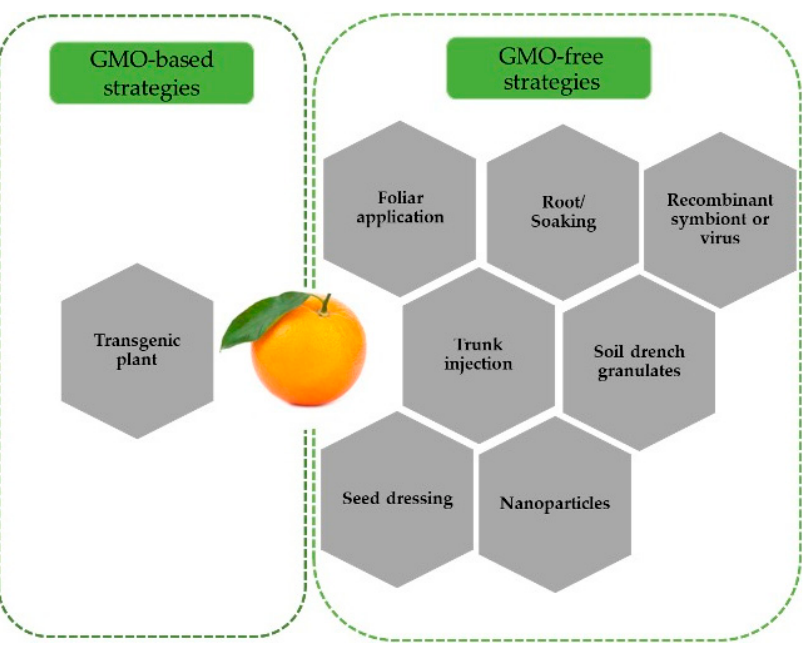
Figure 1. Novel approaches to RNA interference (RNAi)-mediated insect control—delivery strategies. GMO-based strategies: use of genetically modified plants is the best-known approach to RNAi-based control of insect pests or vectors. GMO-free strategies: specific genes of target in an insect are silenced using novel approaches.